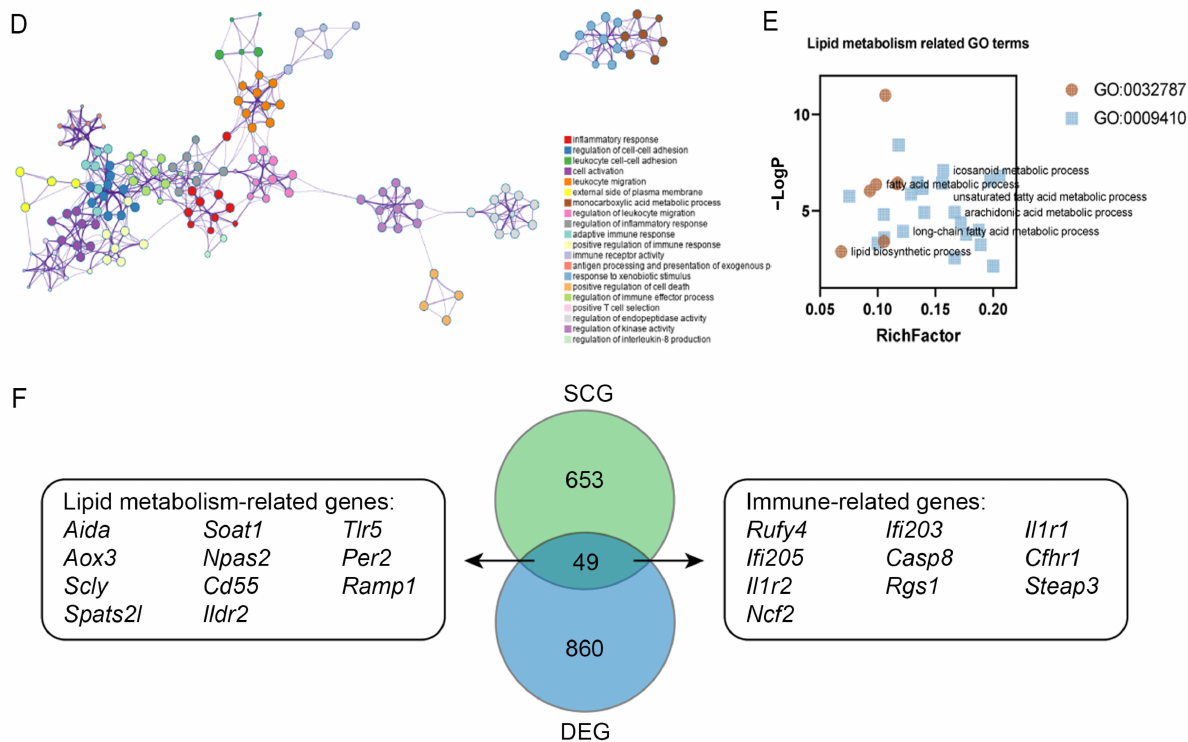
Figure 6. Transcriptome analysis of livers from male B6-Chr1BLD mice. ( A ) Volcano plot of DEGs from male B6-Chr1BLD mice and male B6 mice. ( B ) Enriched KEGG terms. ( C ) Top 20 enriched GO terms. ( D ) Enriched ontology clusters colored by cluster ID. ( E ) Lipid metabolism-related GO terms. ( F ) A Venn diagram showing the overlap between SCGs and DEGs. Lipid metabolism and immune-related genes are